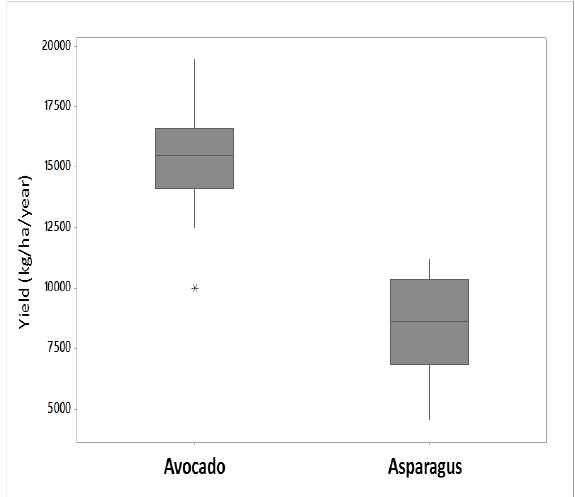
Figure 10. Yield (kg ha−1 year−1) of avocado and asparagus farms in 2017.